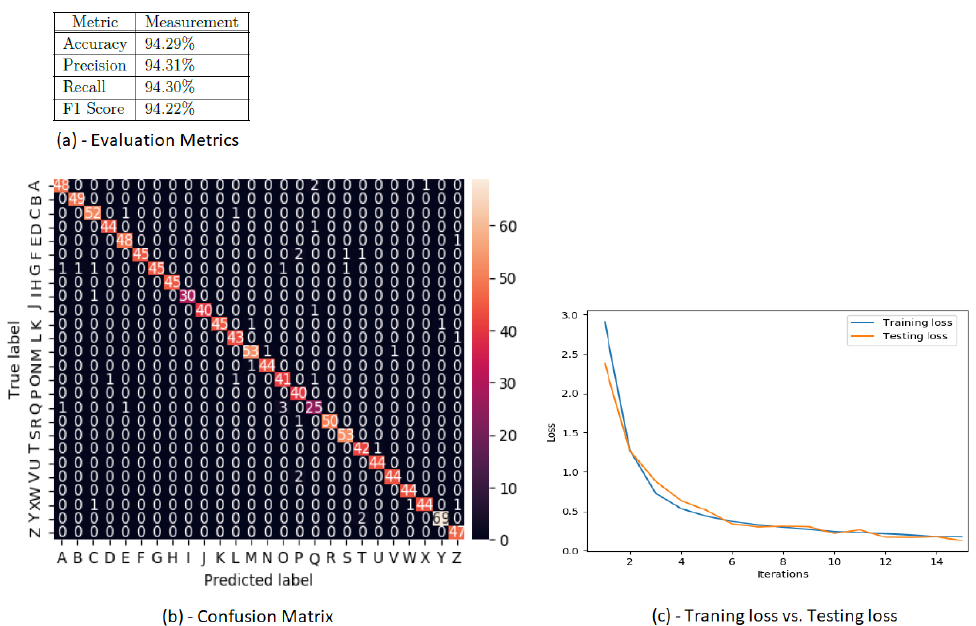
Figure 4. Performances in the recognition of single characters.